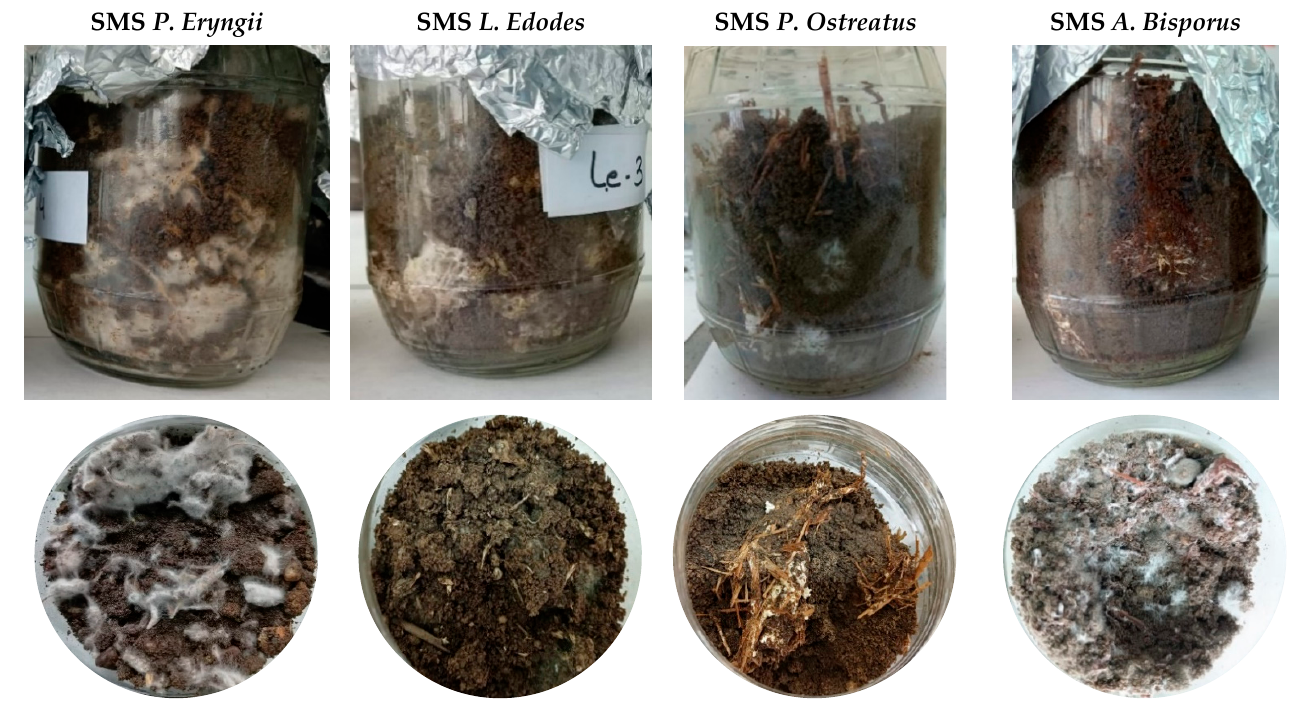
Figure 1. Visual state of the bioaugmented microcosms with four different SMS ( P. eryngii , L. edodes , P. ostreatus and A. bisporus ) after 40 days of incubation.